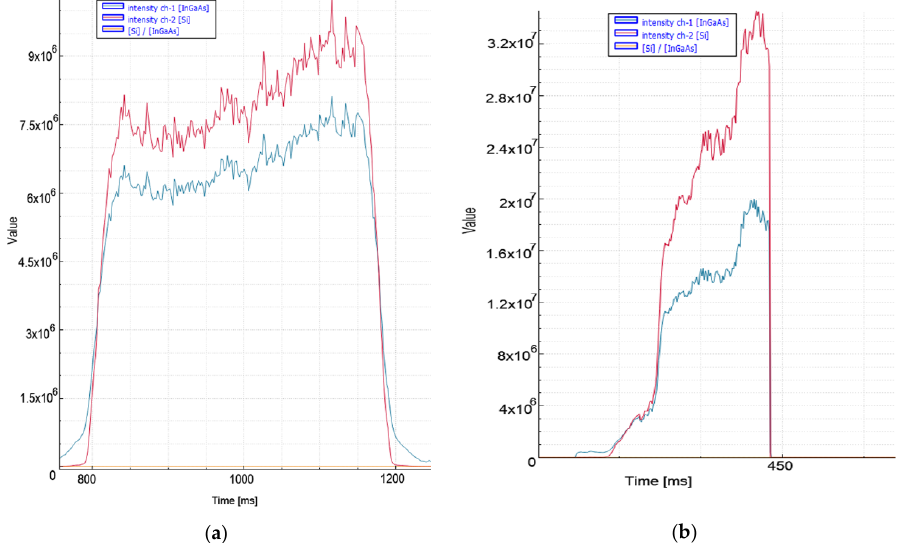
Figure 11. Measurement values recorded during nitrogen cutting of 3 mm mild steel material: ( a ) quality cut with ideal parameters, ( b ) the moment of deterioration of cut and quality.